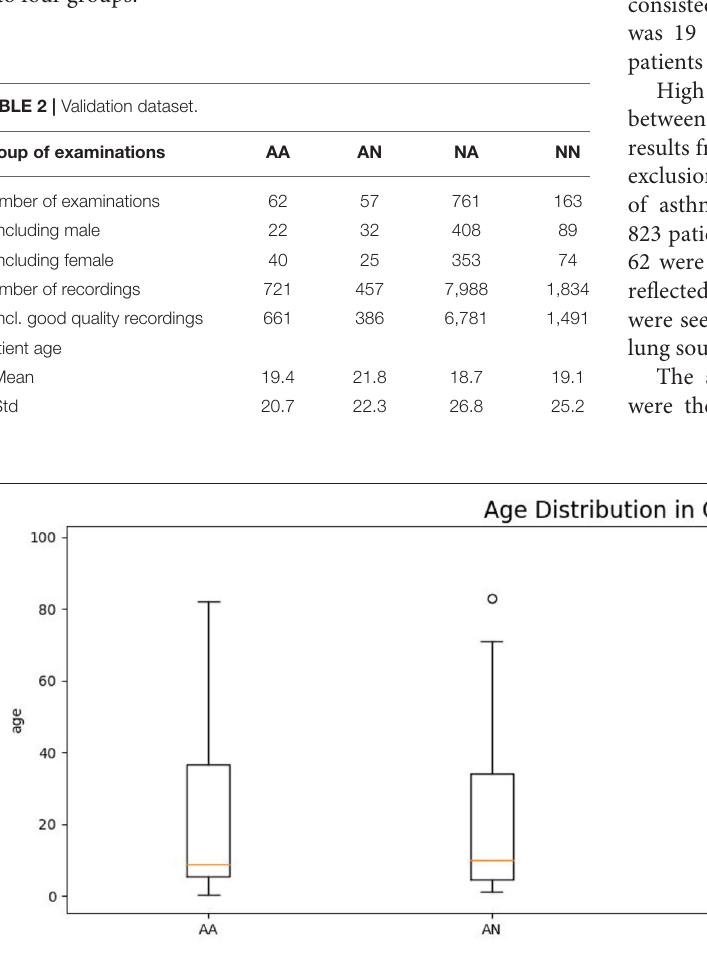
Frontiers in Physiology |